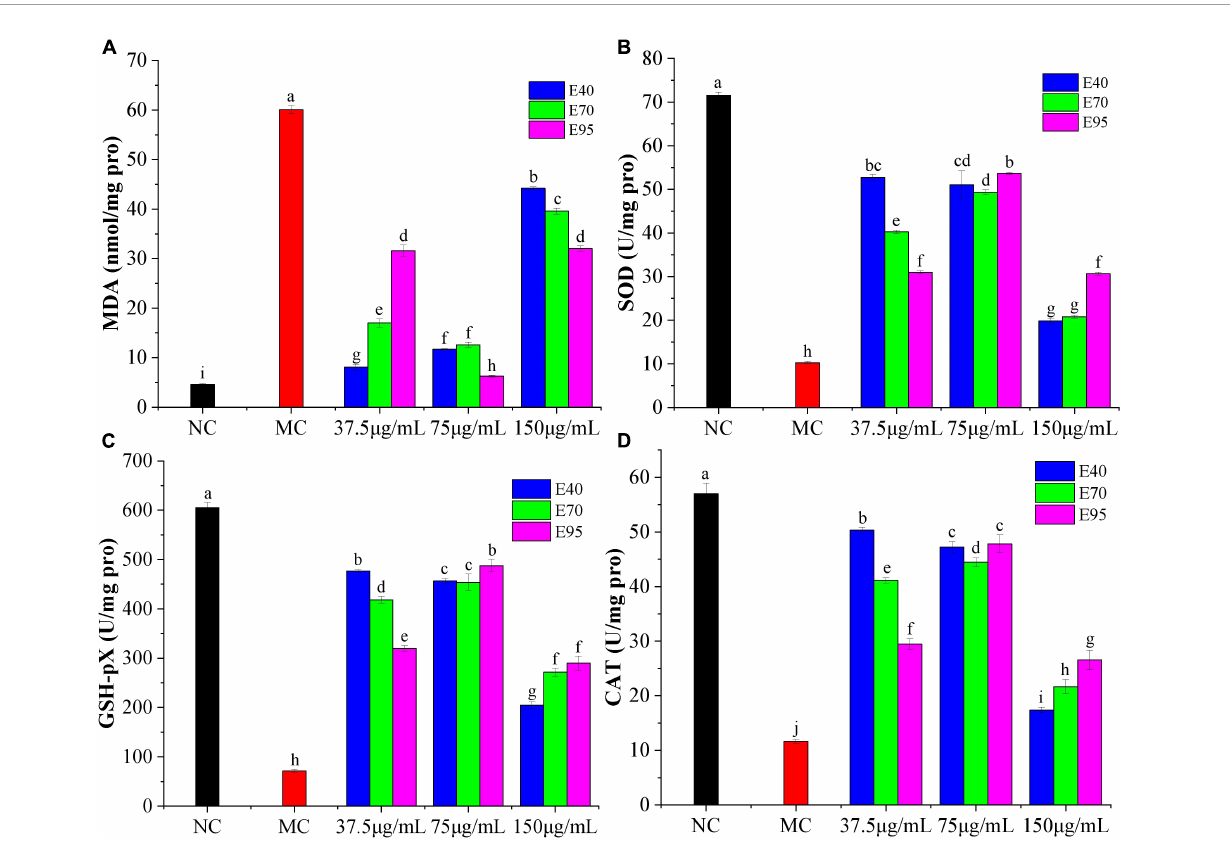
FIGURE3 Effects of different concentrations of PRA extracts on the levels of MDA (A) , SOD (B) , GSH-Px (C) , and CAT (D) in H 2 O 2 -induced HepG2 cells. The different letters (a, b, c, etc.) upper each column indicate that there are significant differences among the data ( P <